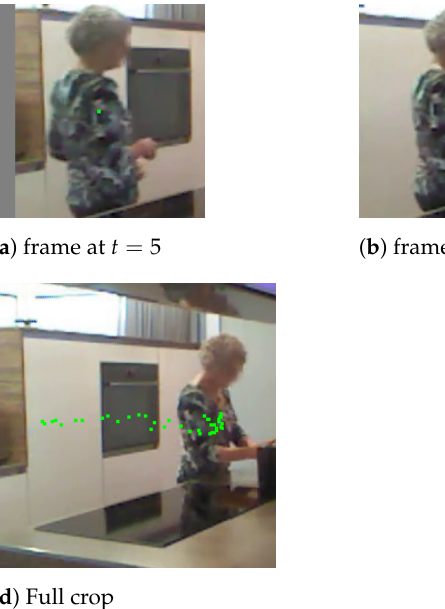
Figure 1. Demonstration of the ‘full crop’ concept. Top row ( a – c ) show the crops of three frames of a ‘Walk’ sequence 5 frames apart (green dots represent centre of detection). Bottom row ( d ) shows the full activity crop for the last frame of the same ‘Walk’ sequence (green dots represent centre of each detection throughout